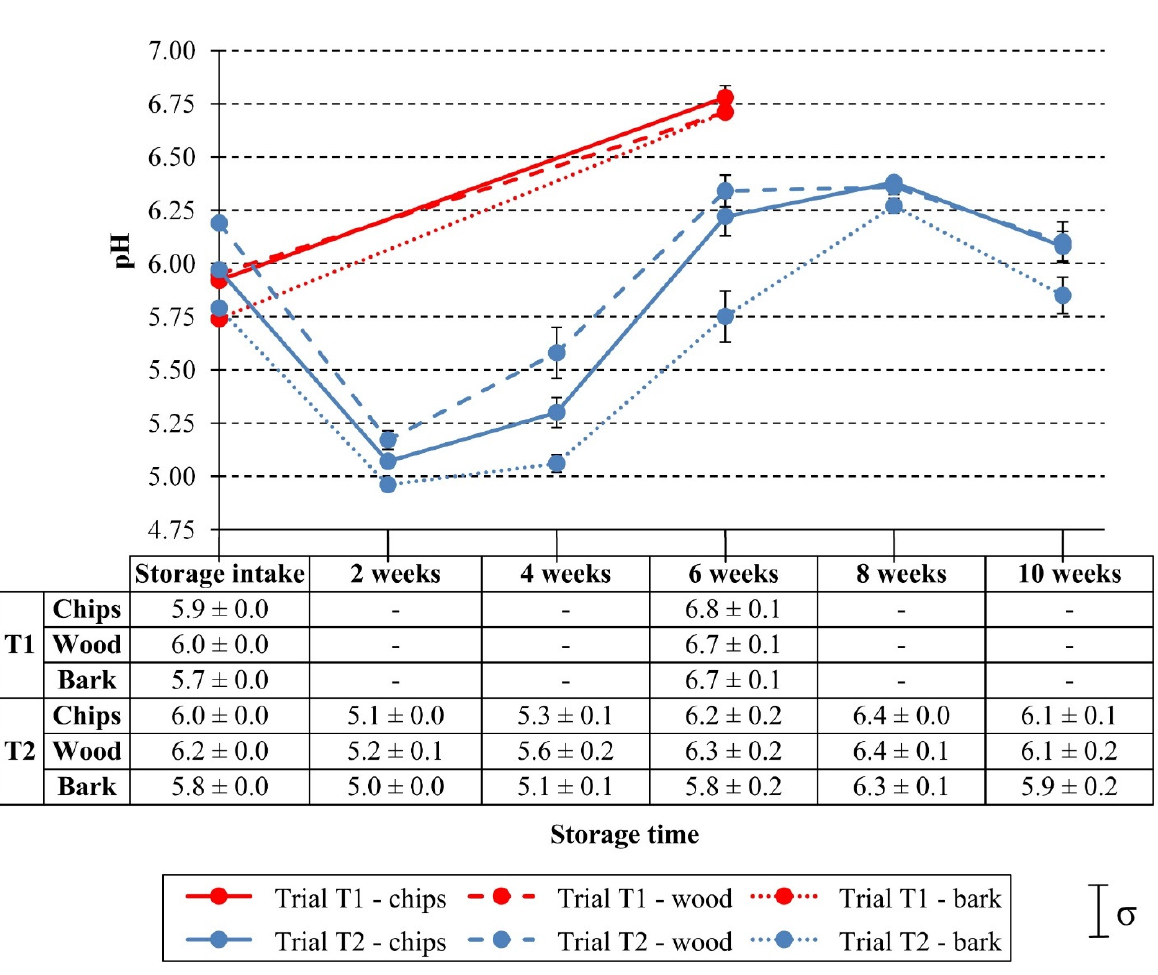
Figure 6. The pH data of wood chips as a function of storage trials (T1 and T2) and time (0–10 weeks); presented as mean ( n = 2 and n = 3 for the storage intake and storage times, respectively) ± standard deviation.